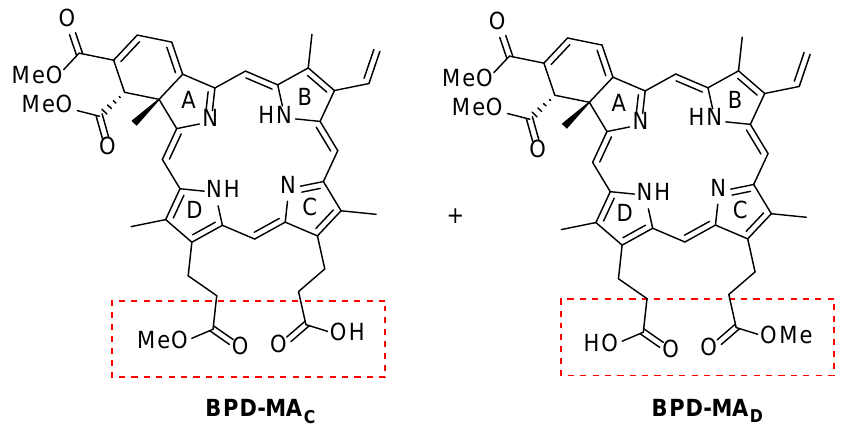
Molecules 2022 , 27 , x FOR PEER REVIEW